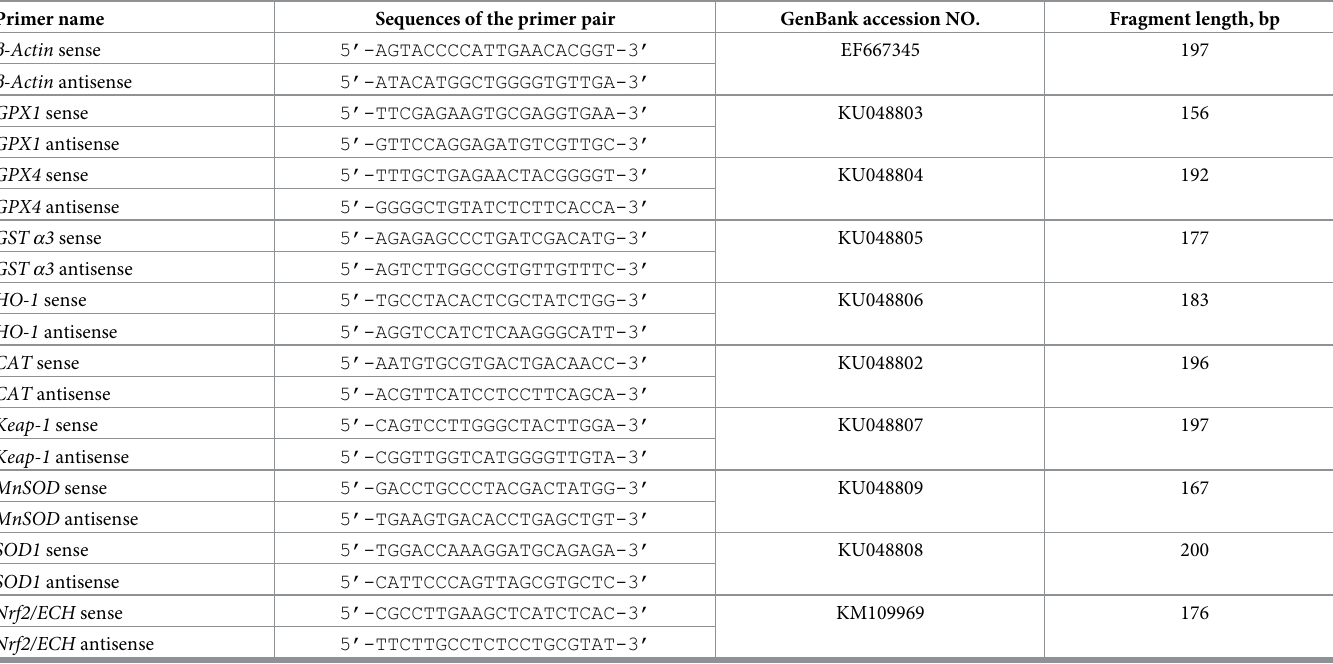
Table 2. Oligonucleotides sequence used for real-time quantitative